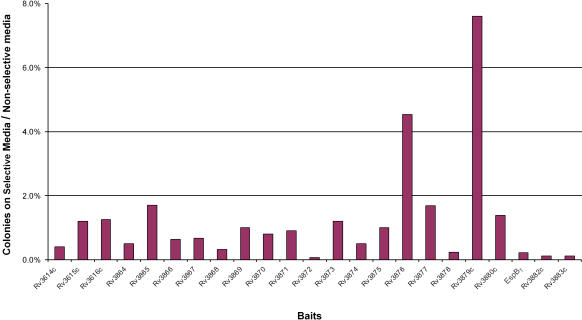
Bacterial Two-Hybrid Analysis of Interaction of EspBT with Proteins of extRD1The target plasmid containing EspBT fused to the RNA polymerase alpha subunit was co-transformed with each of the bait plasmids containing the indicated extRD1 proteins fused to the lambda repressor into the reporter validation strain. Shown is the ratio of growth of the co-transformants on selective (+5 mM 3AT) versus non-selective plates. The experiment depicted is representative of three independent determinations.